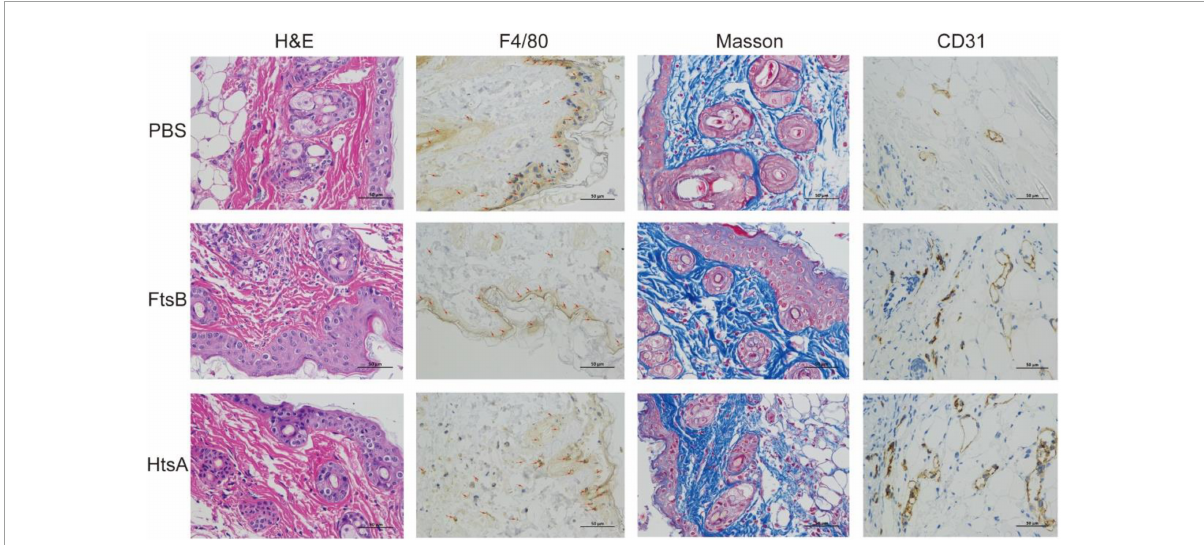
FIGURE6 In the skin infection model, immunization with the FtsB protein reduced inflammation at the mouse skin lesions, promoted vascular endothelial regeneration and accelerated wound healing. The skin pathological conditions of the mice were monitored 48 h after challenge with S. pyogenes . F4/80 is a marker of macrophages, and CD31 is a marker of vascular endothelium (400 × ). The brown in the figures represent F4/80- or CD31-positive